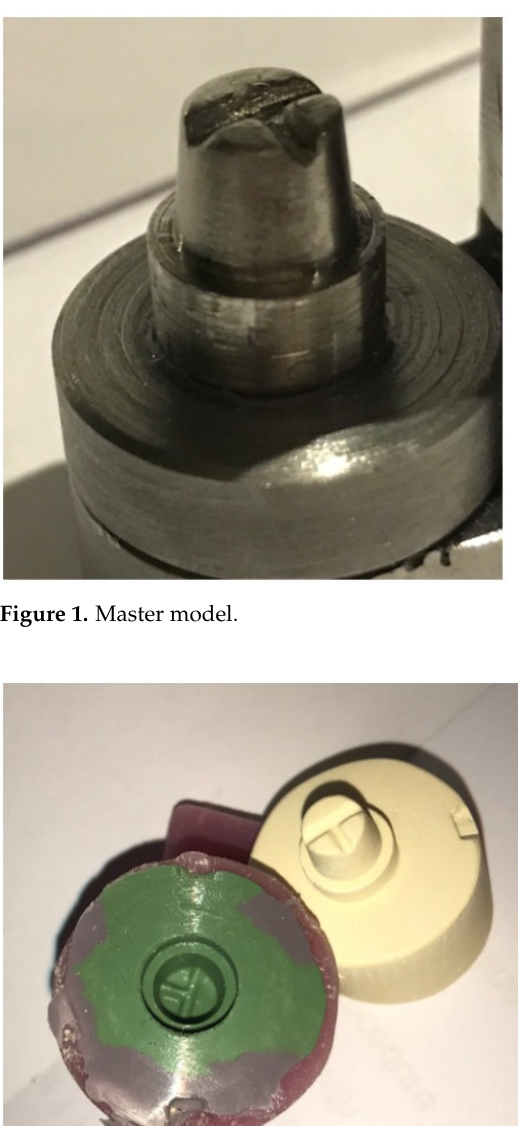
Figure 2. Impression and stone model.